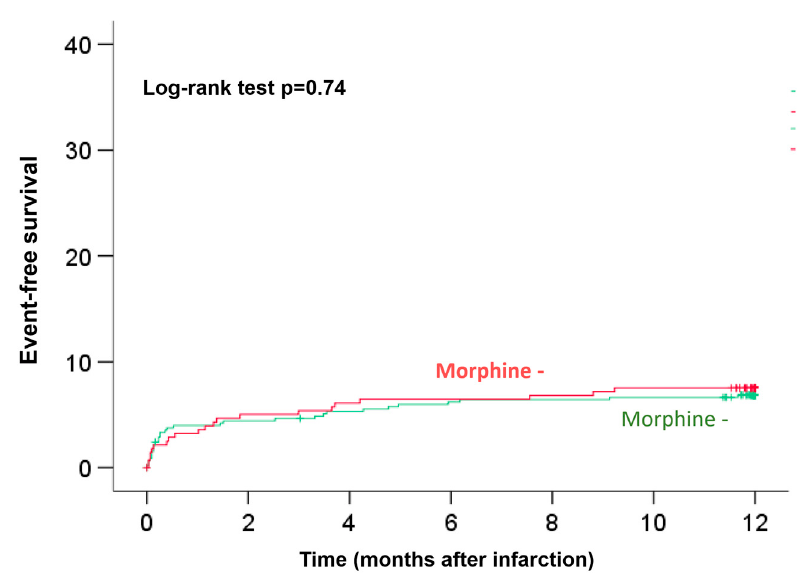
Figure 4. Twelve-month survival according to morphine use. Kaplan–Meier plots with log-rank testing for event-free survival at the 12-month follow-up. There were no significant differences between the two groups (Log-rank test p ＝ 0.74).